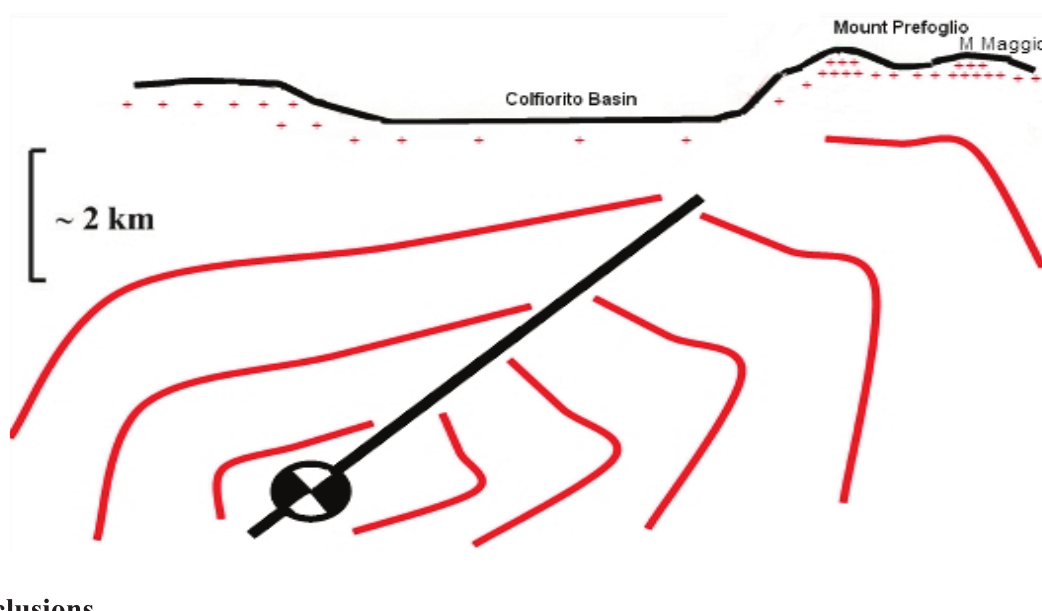
Figure 6. Surface profile extracted from Figure 1b, showing the Colfiorito plain, Monte Prefoglio (and Monte Maggio behind it) relative to the fault geometry which generated the Umbria-Marche earthquake; + symbol represents the charge distribution on the ground